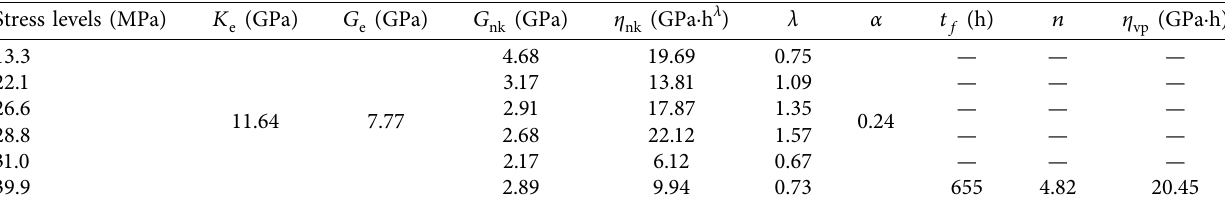
Table 3: Model parameters under triaxial creep for